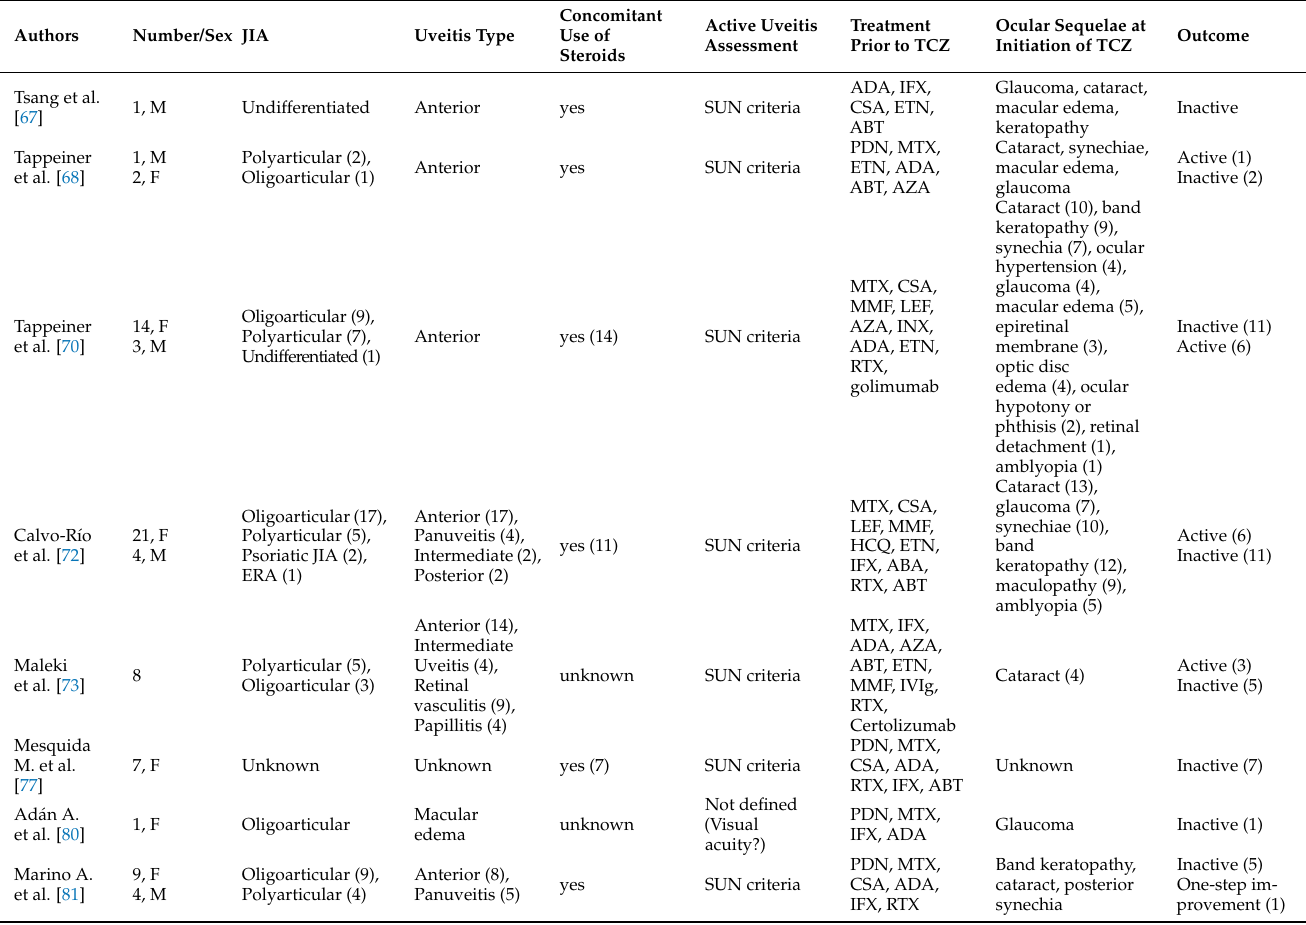
Table 1. Tocilizumab in U-JIA